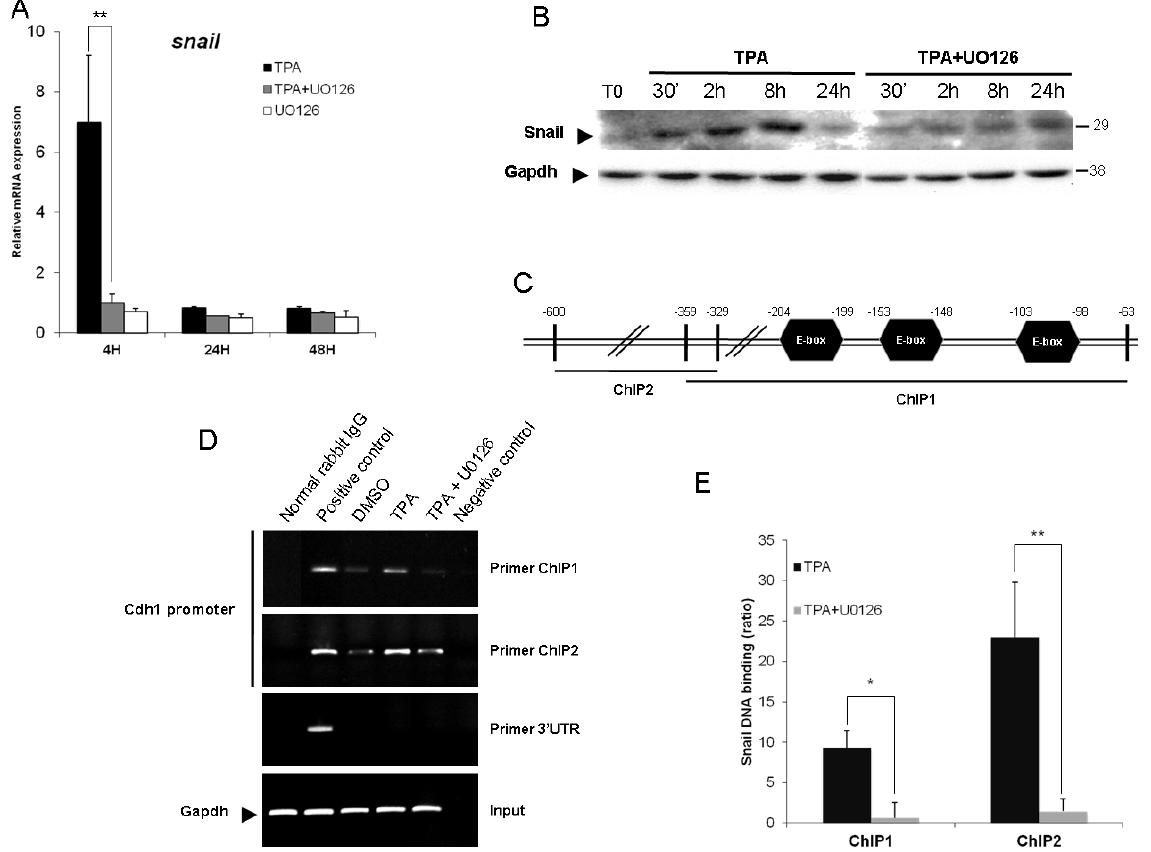
Figure 4. The binding of Snail to the E-box of the CDH1 promoter requires ERK1/2 activation. ( A ) Levels of Snail mRNA were assessed by real-time RT-PCR. The HepG2 cells were stimulated with 100 nM TPA, with or without U0126, for 4 h, 24 h and 48 h. Relative mRNA expression levels (with respect to gapdh ) were determined, with the mRNA levels in DMSO-treated cells set to 1; ( B ) Total proteins were extracted after 30 min, 2 h, 8 h and 24 h and the expression level of Snail was examined by western blotting. As a control, the same membranes were also probed with an antibody directed against Gapdh; ( C ) Diagram of the CDH1 promoter showing the amplification site used for ChIP analyses; ( D ) HepG2 cells were exposed for 4 h to 100 nM TPA with or without U0126. Rabbit anti-Snail, normal rabbit IgG (negative control) and mouse anti-RNA Pol II (positive control) antibodies were used for immunoprecipitation. Input DNA, together with immunoprecipitated and purified DNA, was used for the amplification by PCR of a 296 bp (ChIP1) or a 271 bp (ChIP2) fragment specific to the CDH1 promoter; ( E ) Band intensities were assessed by densitometry after image acquisition with a CCD camera and the results are presented as the ratio between the value for treated cells to that for DMSO-treated cells, both these values being normalized according to input (means ± SD for three experiments). The data presented are representative of three independent experiments. * p < 0.05; ** p <